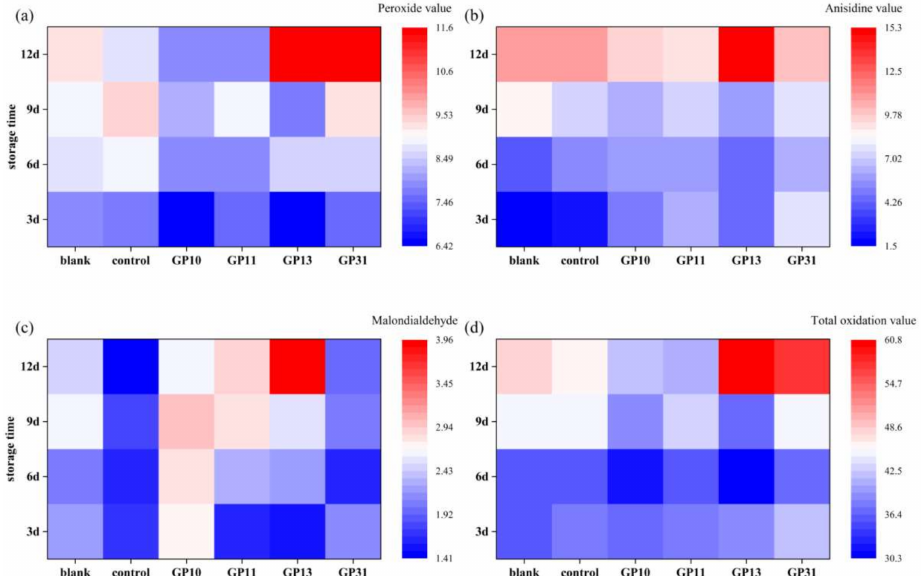
Figure 8. Degree of liver oil oxidation during storage, ( a ) liver oil peroxide value (PV, mmol/kg), ( b ) anisidine value (An.V, dimensionless), ( c ) malondialdehyde (MDA, mg/kg), ( d ) total oxidation value (TOV, dimensionless), at 3d, 6d, 9d,